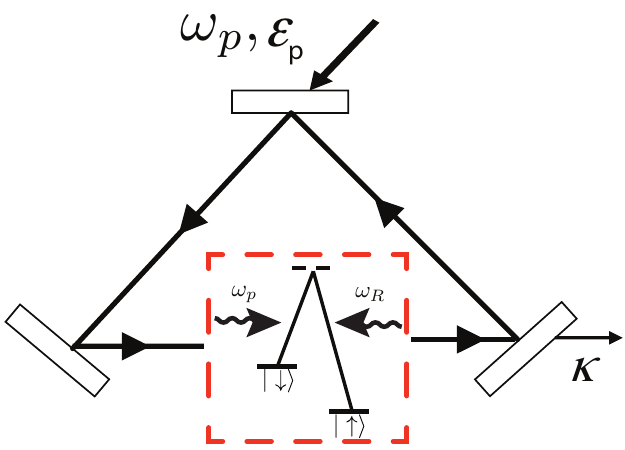
Figure 1. Schematic diagram of the cavity-assisted spin-orbit coupled system. Inside the red dashed box, we show the level diagram of the atom and the light field configuration where ω represents the cavity field and ω p cavity pumping rate and decay rate,